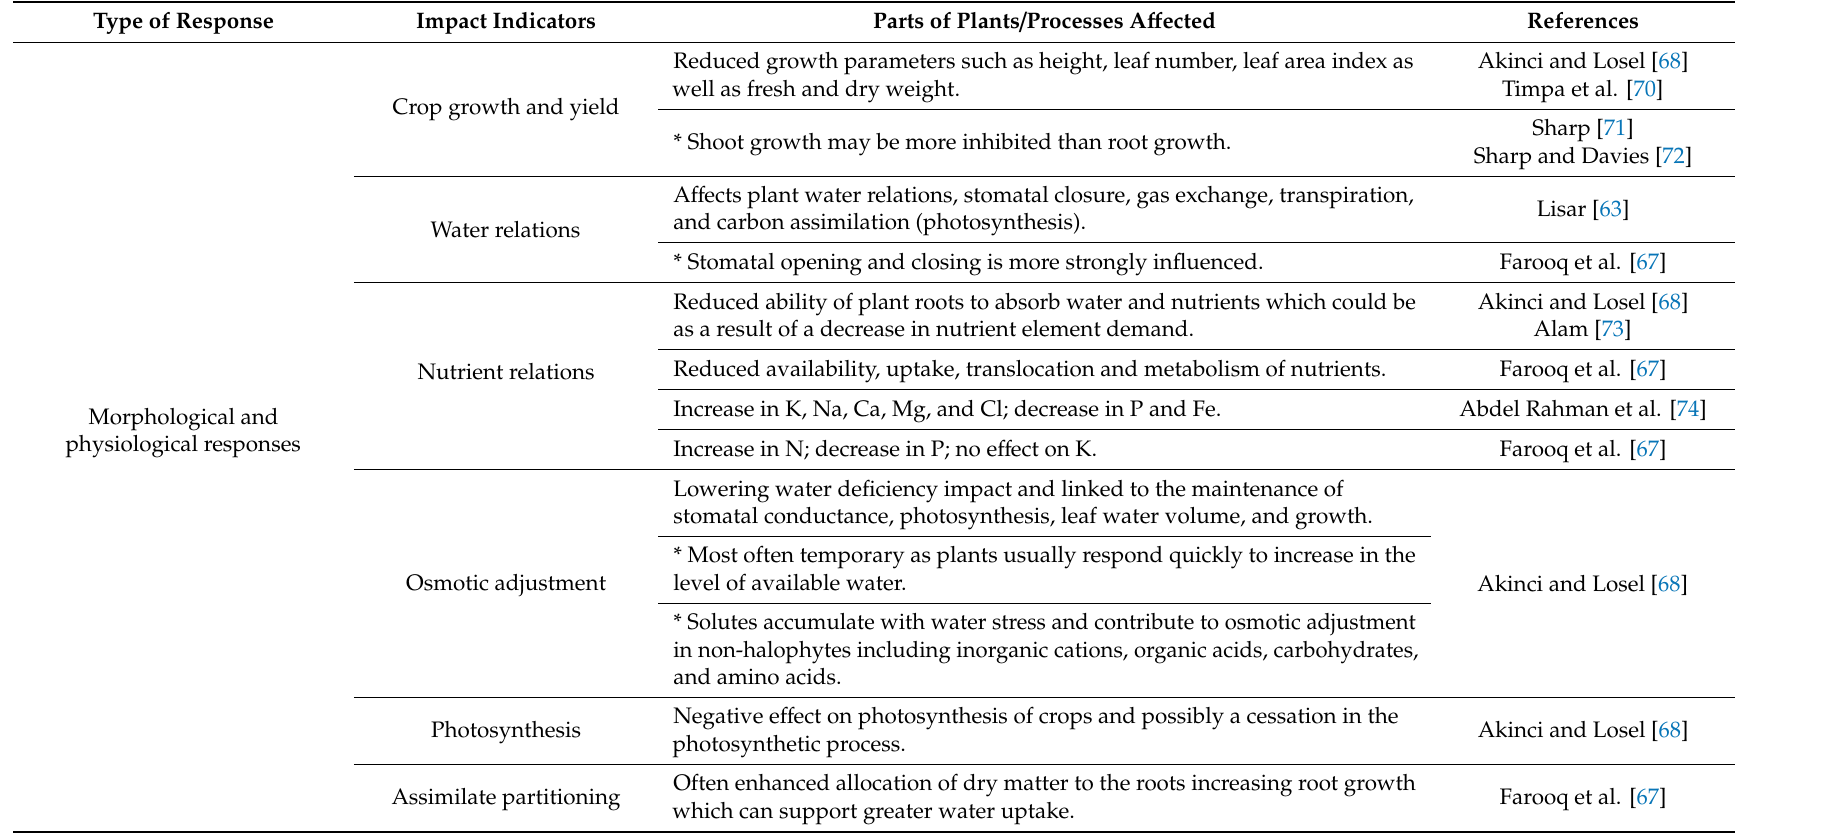
Table 2. Summary of plants’ responses to water